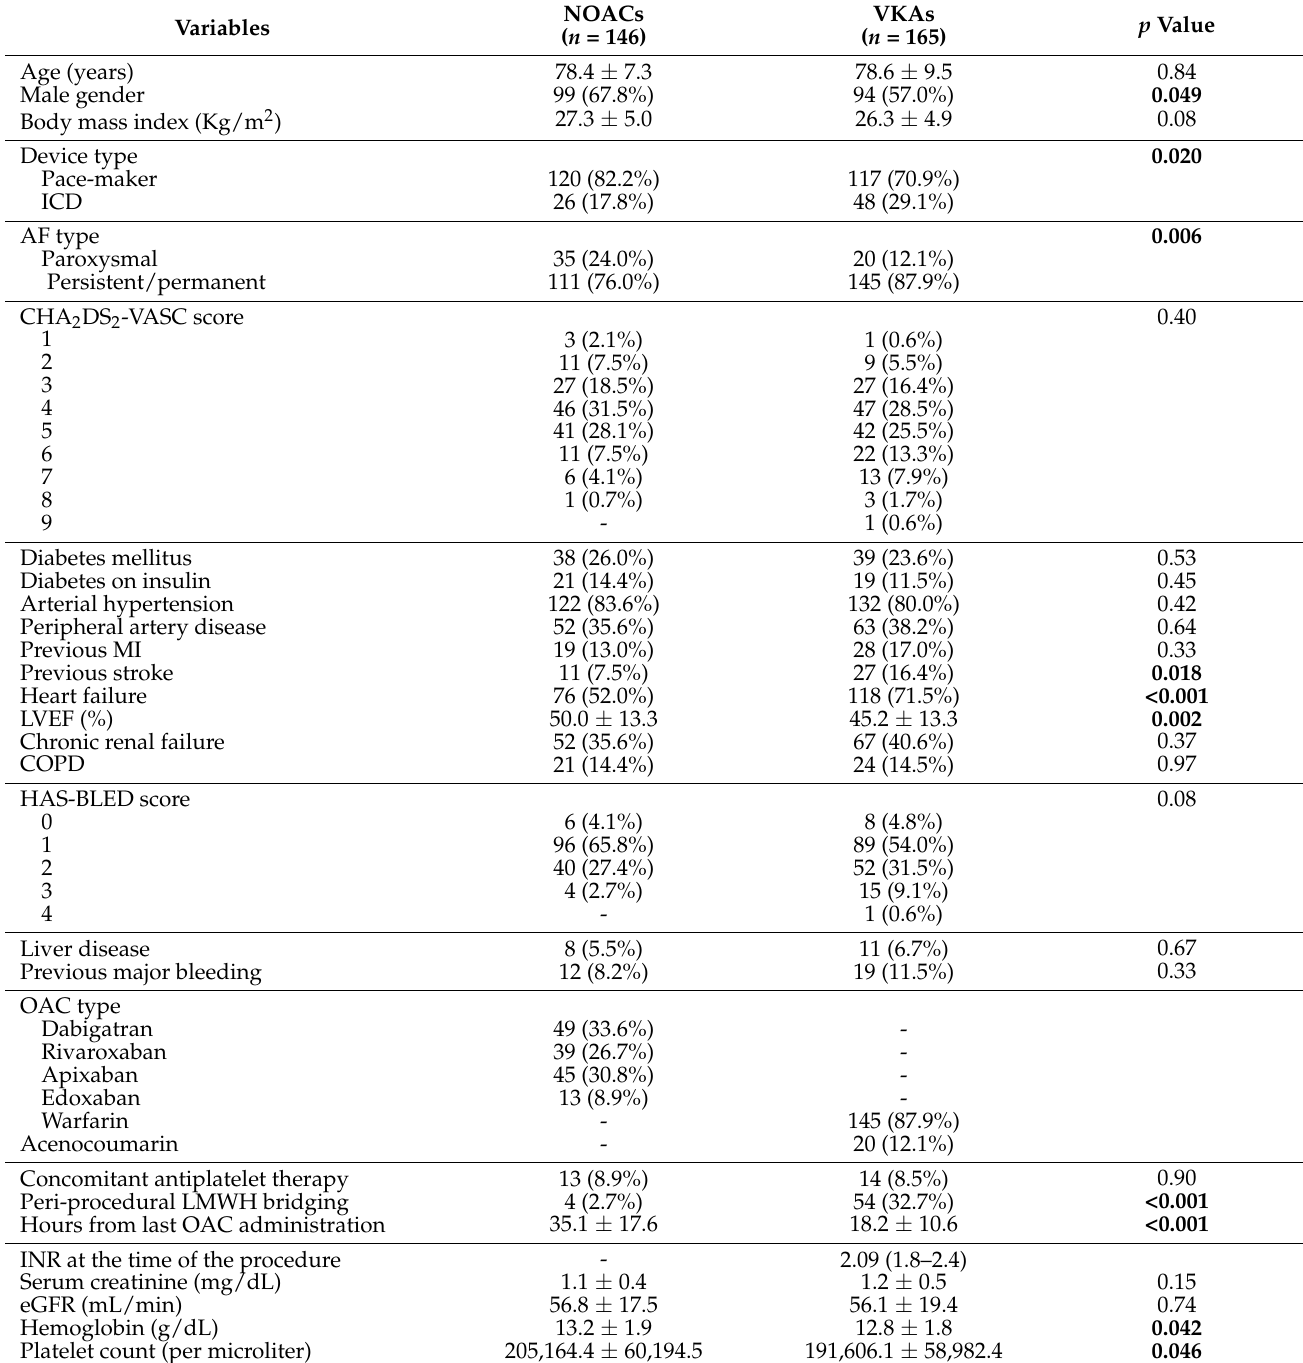
Table 1. Main demographic/clinical and laboratory data at baseline in the included